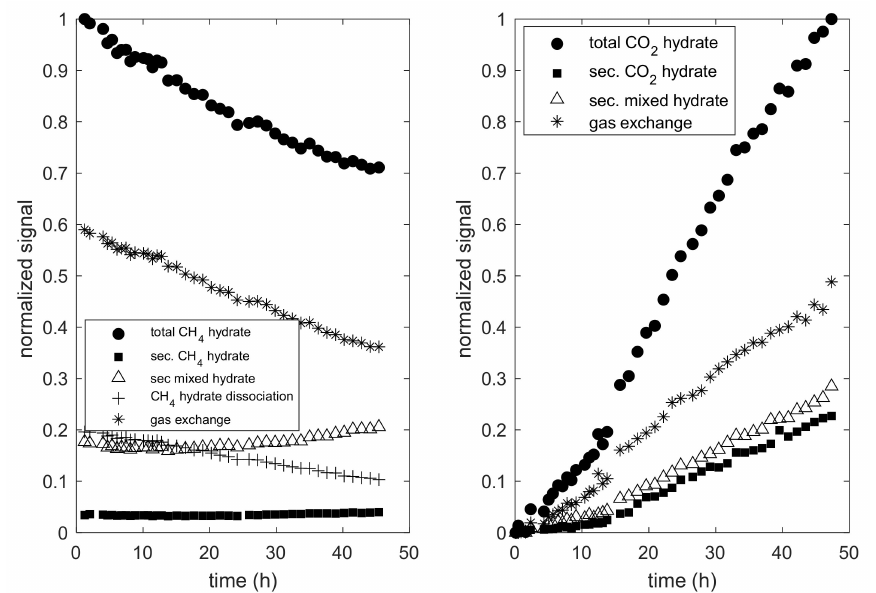
Figure 7. Evolution of the total gas-hydrate signal of experiment NoFlowI1 and evolution of the specific processes. Left: CH 4 hydrate; right: CO 2